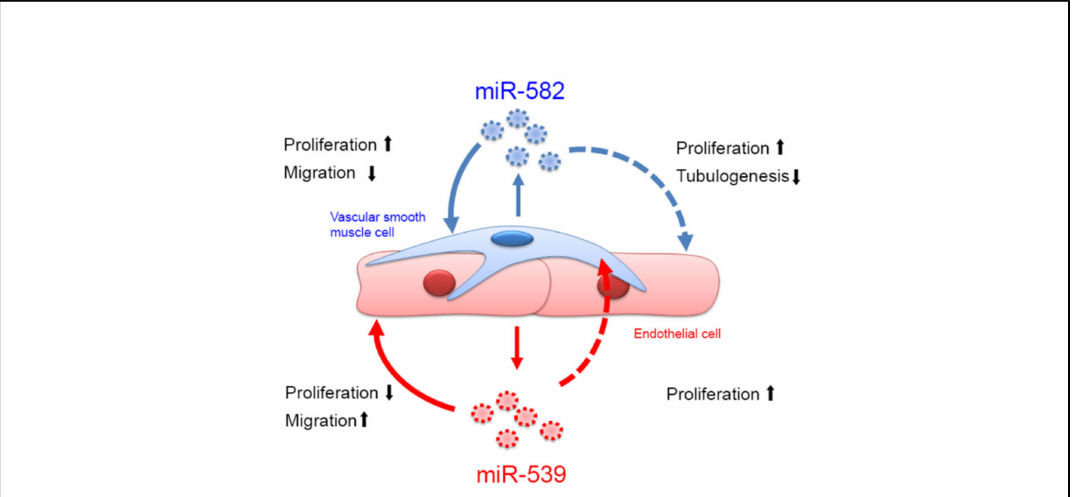
Figure 6. ECs and SMCs communicate via the exchange of microRNAs-loaded EVs. The coculture of ECs and SMCs induces a modification to the microRNAs’ cargo of EVs. After the coculture, ECs EVs are enriched in miR-539 while SMCs EVs are enriched in miR-582; then, cells exchange their EVs, inducing some modification to their cellular